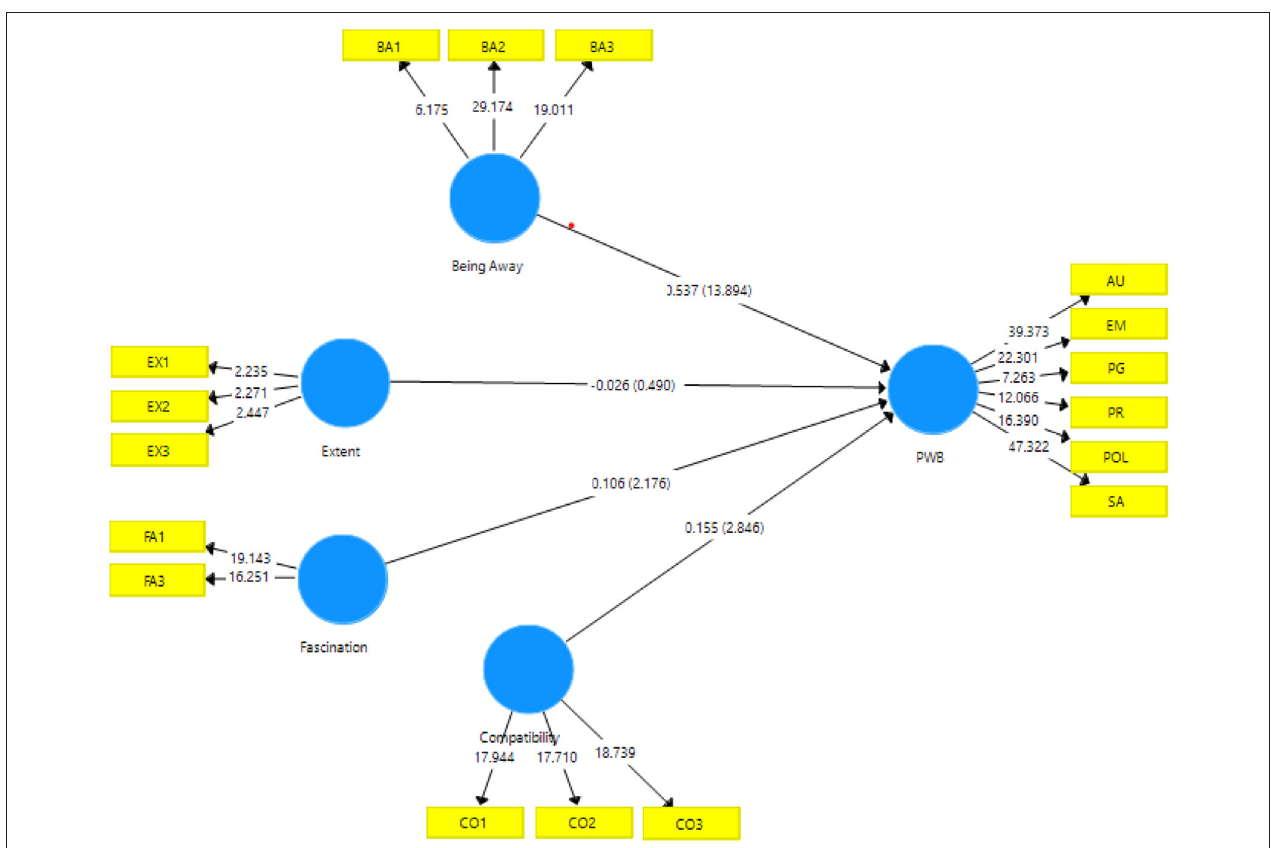
FIGURE 1 | The results of standardized regression